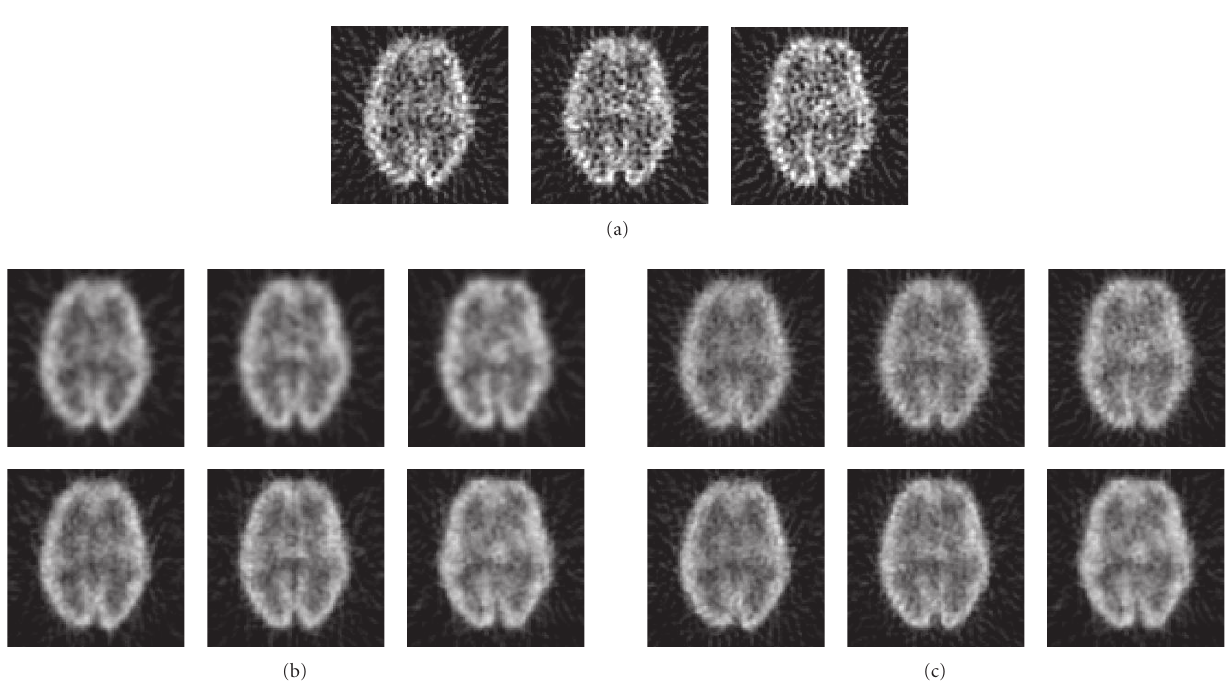
Figure 10: Three transaxial slices of the physical Ho ff man phantom. In (a), FBP-reconstructed images without any noise reduction. In (b), radial sinogram filtering: FBP images for Gaussian filtering (top row) and for L-filtering (bottom row) at the matched resolutions (see Figures 4 and 5). In (c), angular stackgram filtering: FBP images for Gaussian filtering (top row) and for L-filtering (bottom row) at the matched resolutions (Figures 4 and 5). The noise variation seems to be higher after angular stackgram filtering (c) in comparison with radial sinogram filtering (b). All images share a common grayscale.